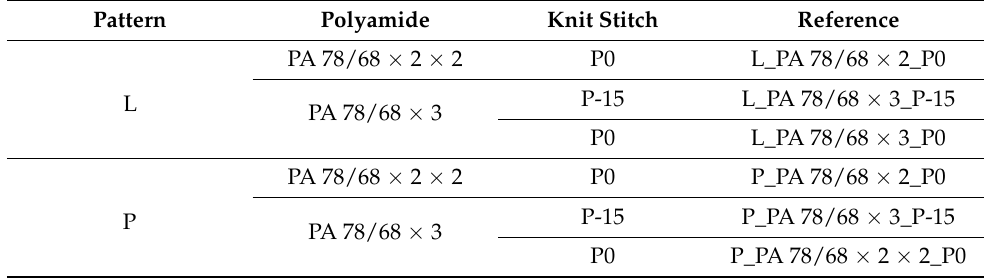
Table 1. Knits studied in the present study. Pattern Polyamide Knit Stitch